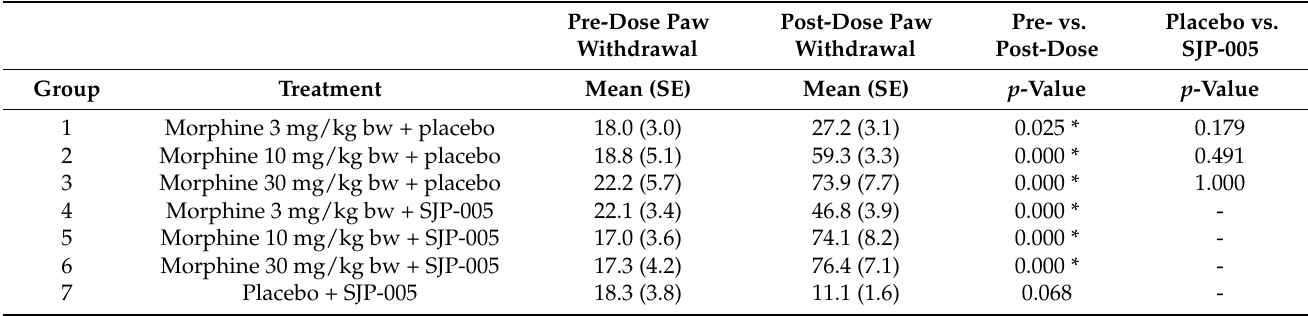
Table 2. Paw withdrawal